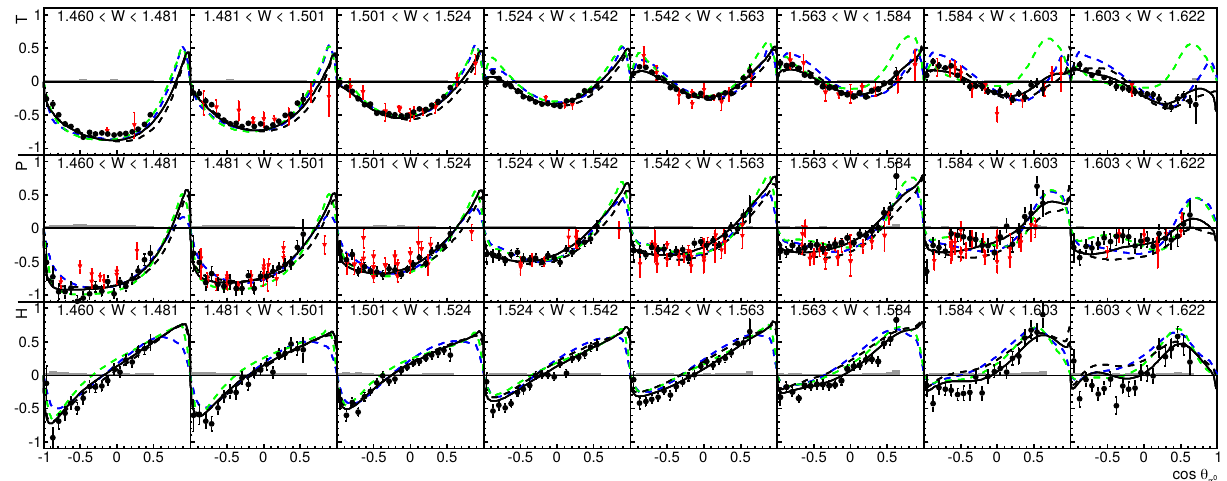
Figure 5. The results for the polarization observables T , P and H are shown for selected energy bins for the p π 0 final state (black points). The data is compared to previous measurements (red points) [44] and to di ff erent PWA predictions (dashed curves: BnGa-2011 (black) [42], MAID (green) [18], and SAID CM12 (blue) [17]) and PWA fit (BnGa-2014-02 (blak solid line) [15, 41]). Taken from [10].